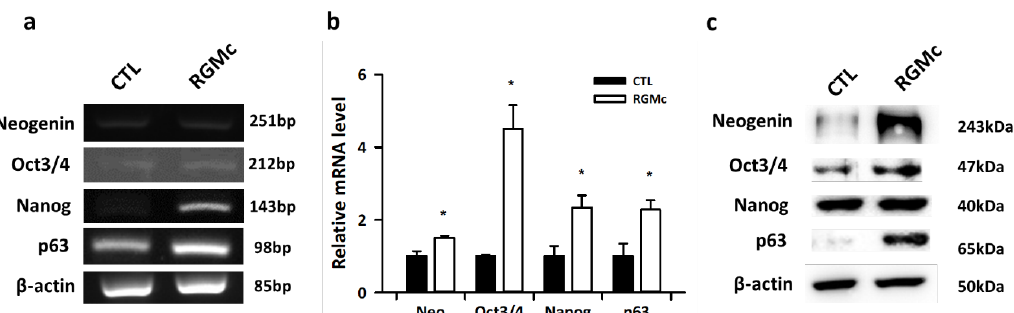
Figure 3. mRNA and protein expression in RGMc-treated ovaries. ( a ) RT-PCR analysis of neogenin (Neo), Oct3/4, Nanog, and p63 expression in control (CTL) and RGMc-treated ovaries. ( b ) Quantitative real-time PCR analysis of relative expression of neogenin (Neo), Oct3/4, Nanog, and p63 in control (CTL) and RGMc-treated ovaries. ( c ) Western blot analysis of neogenin (Neo), Oct3/4, Nanog, and p63 expression in control (CTL) and RGMc-treated ovaries. β-actin was used as an internal control. Data are the mean ± SEM of three replicates. * p < 0.05 versus the control group.